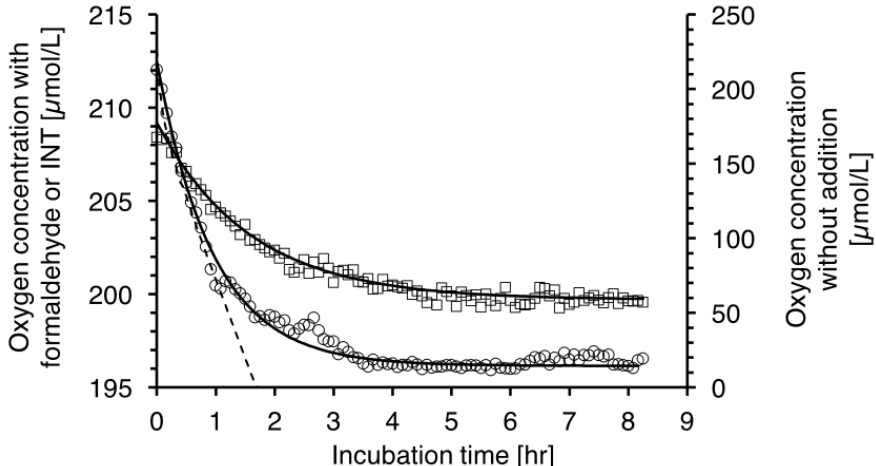
Figure 5. Oxygen concentration over time in enclosed V. harveyi cultures. Note difference in ordinate scales: Left ordinate: Oxygen concentration after addition of INT ( ) and formaldehyde ( ). scales: Left ordinate: Oxygen concentration after addition of INT ( (cid:3) ) and formaldehyde ( Continuous lines represent the exponential decay function fitted to the data including the baseline calculated from the concentrations at > 6 h. Right ordinate, corresponding to the dashed line to avoid cluttering the figure: The oxygen concentration without additions to the